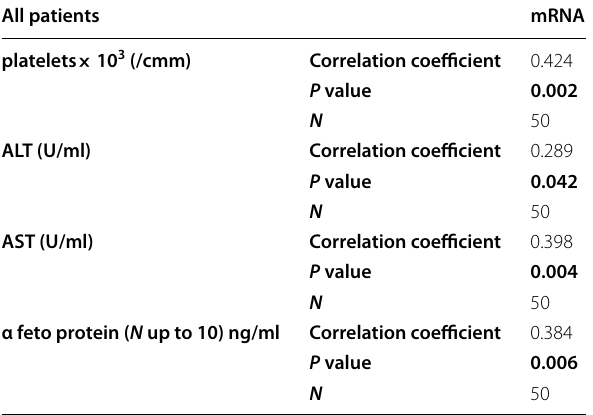
Table 3 The correlation between miRNA 21 and other parameters (ALT, AST, platelet count, and α feto protein) All patients